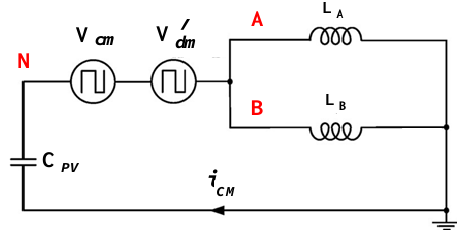
Figure 3. Common mode equivalent circuit.